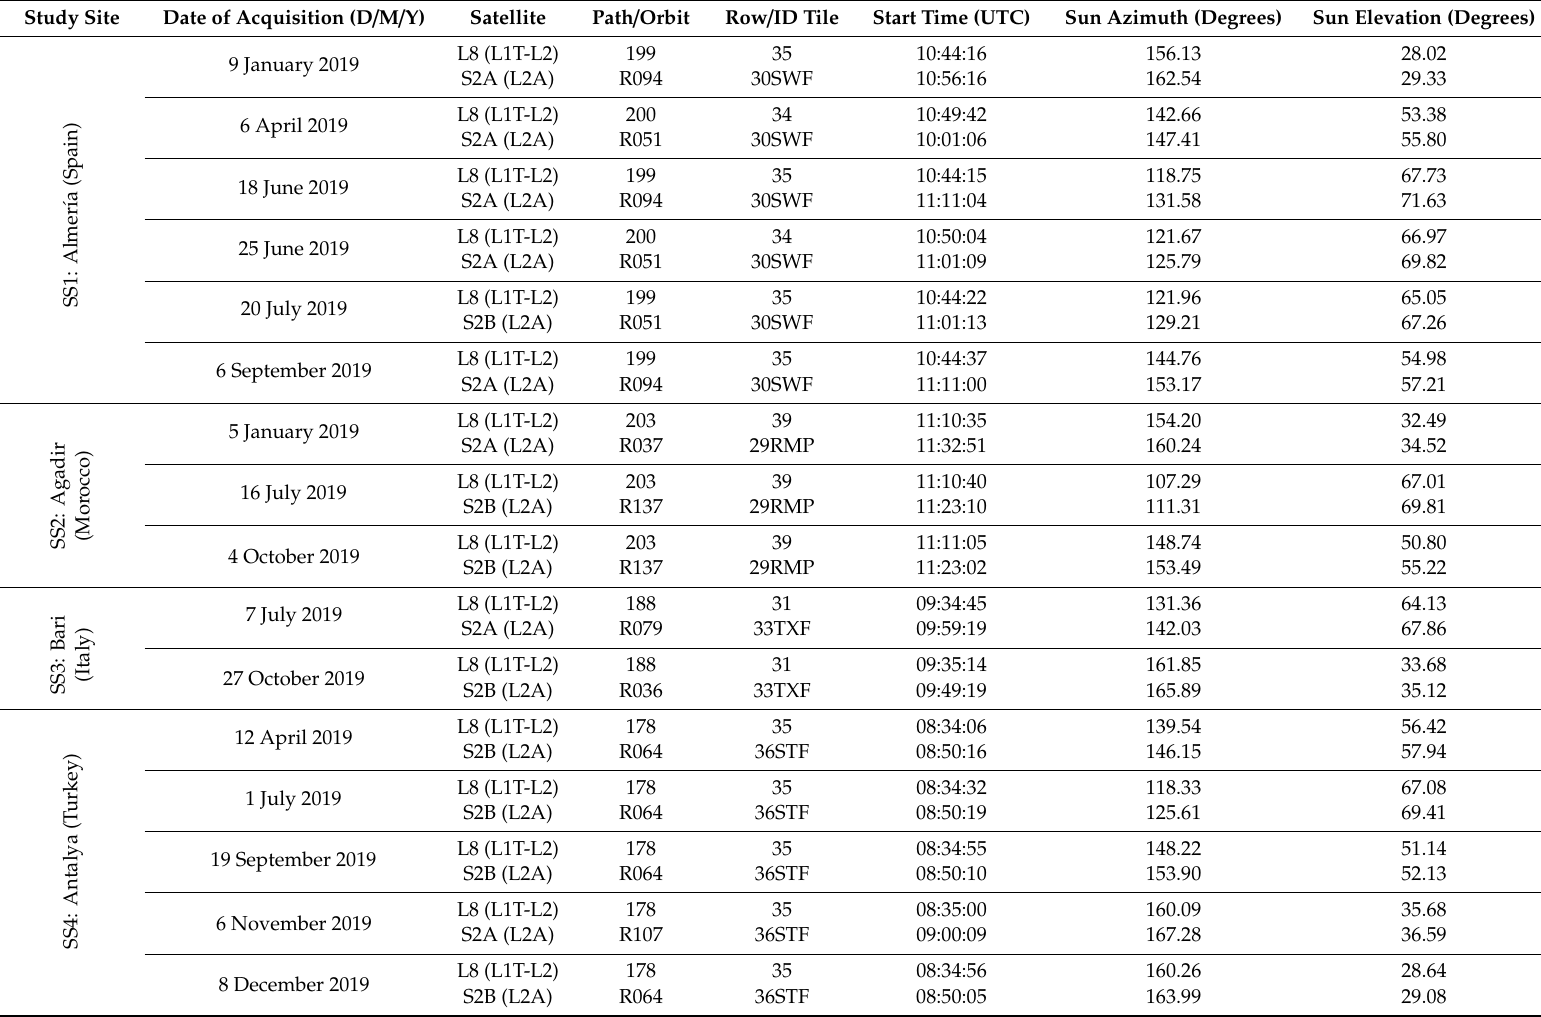
Table 1. Original Landsat 8 OLI (L1T and L2) and Sentinel-2 L2A images used in this